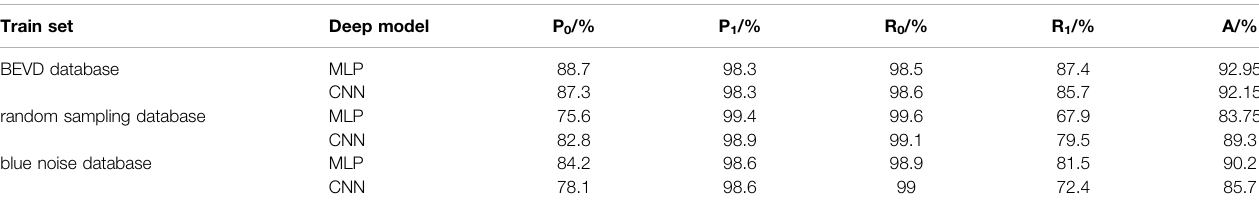
TABLE 2 | Level 2 indicator for the results of